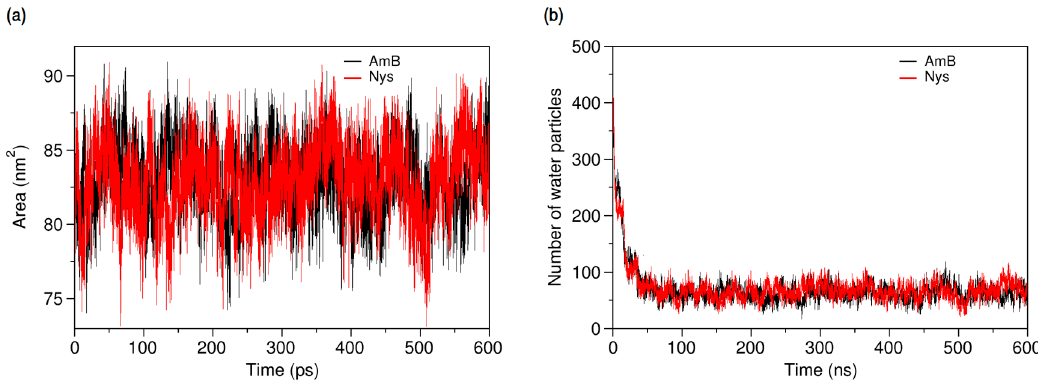
Figure 10. ( a ) Solvent accessible surface area of AmB and Nys molecules; and ( b ) average number of water particles around AmB and Nys molecules within 7 Å, during and after encapsulation into the P80 micelle.